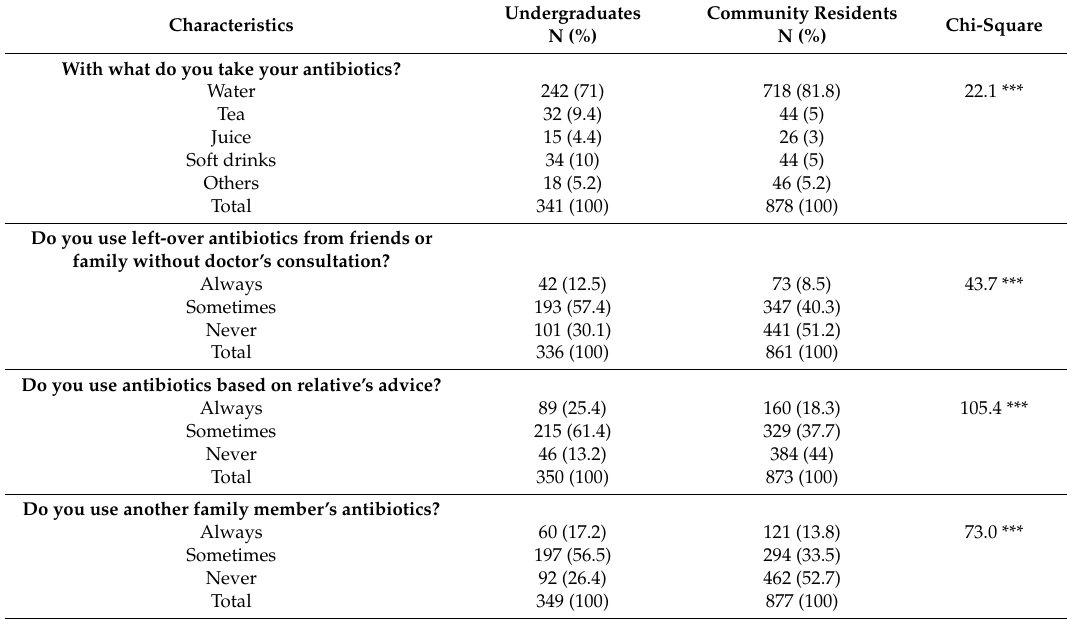
Table 5. Attitude towards antibiotics among community residents and undergraduate